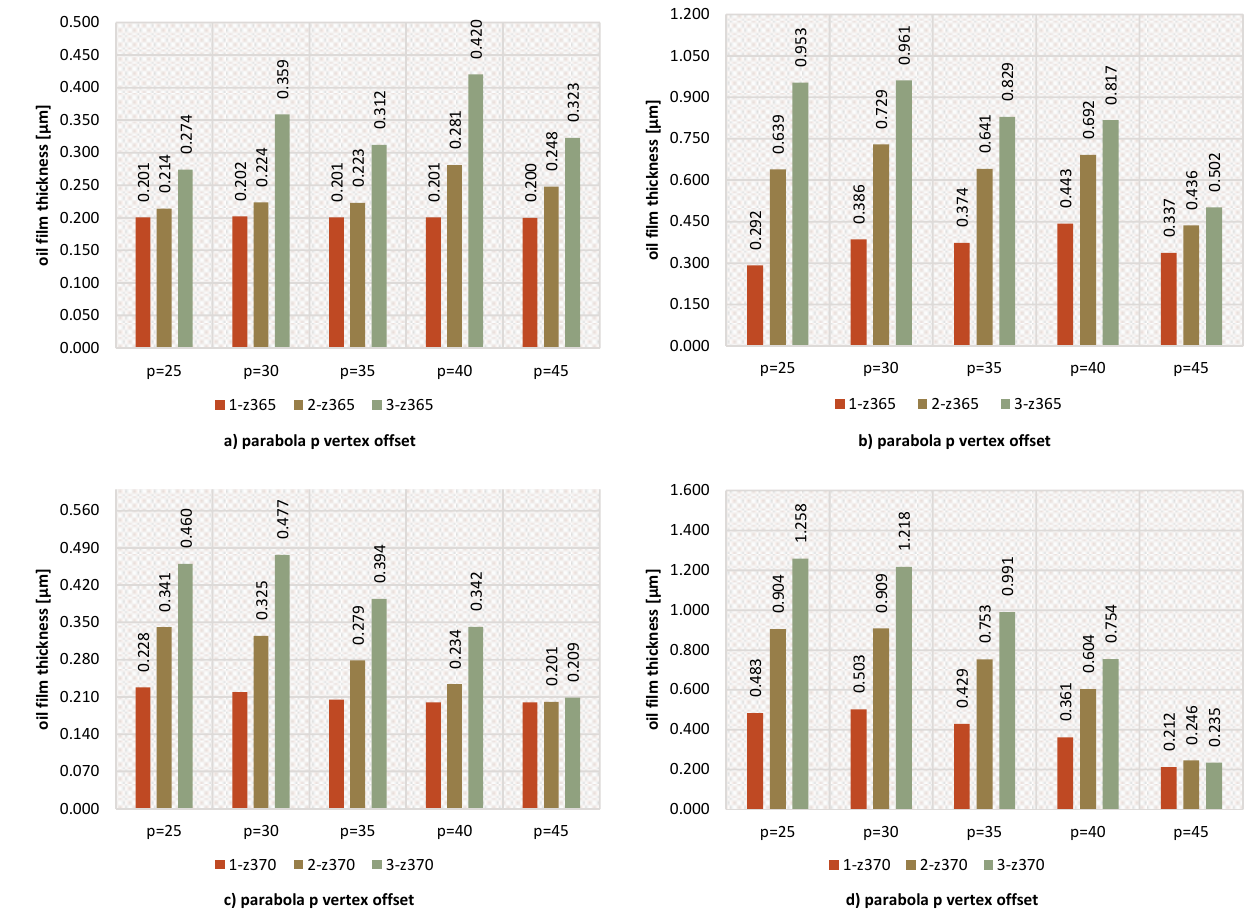
Fig. 4. Oil film thickness on the upper sealing ring slide surface depending on the parabolic vertex coordinate value p j,k-1-2 , where: 1 – 1000 rpm, 2 – 2000 rpm, 3 – 3000 rpm, z365 – the thickness of the oil film at 5° after TDC in the expansion stroke, z370 – the thickness of the oil film at 10° after TDC in the expansion stroke; a), c) for the dynamic viscosity of lubricating oil 0.0120 Pa×s, b), d) for the dynamic viscosity of lubricating oil 0.0386